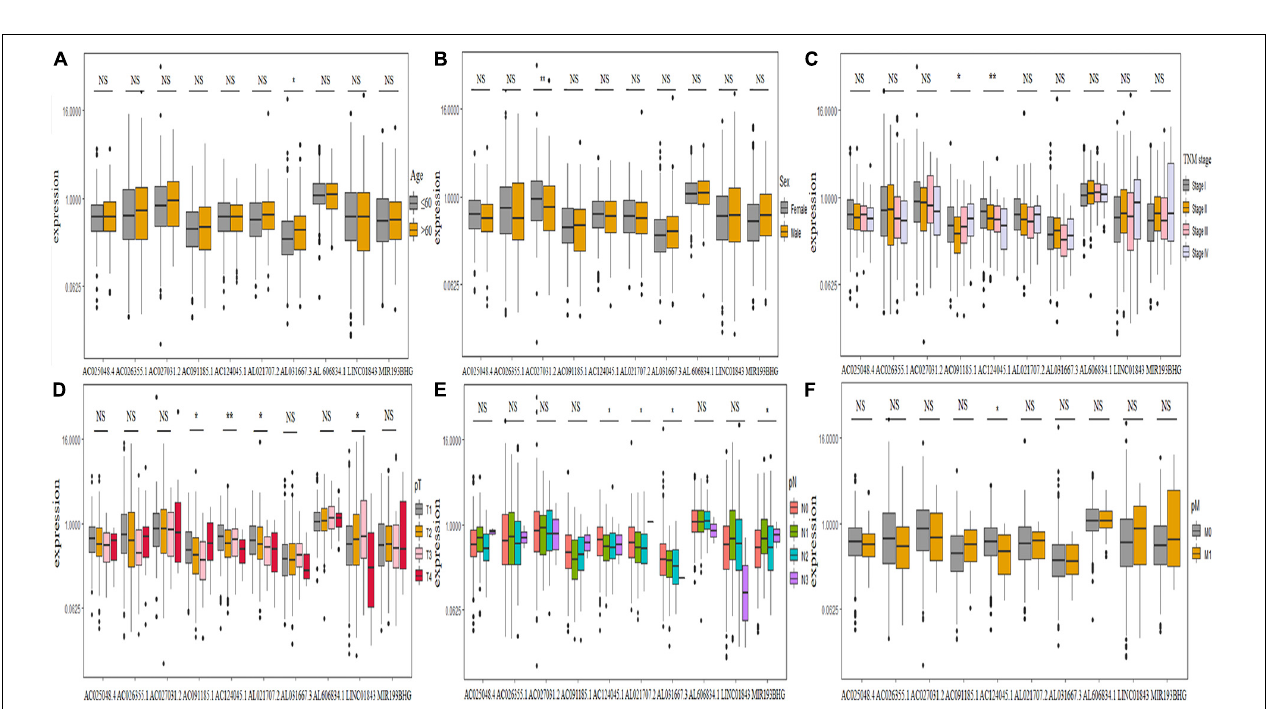
FIGURE 7 | Correlation between the expression level of 10 ferroptosis-associated long non-coding RNAs and clinicopathological characteristics. (A–F) Age, sex, TNM stage, pT stage, pN stage, and pM stage, respectively. TNM, tumor node metastasis; NS, not significant. * P < 0.05; ** P < 0.01.